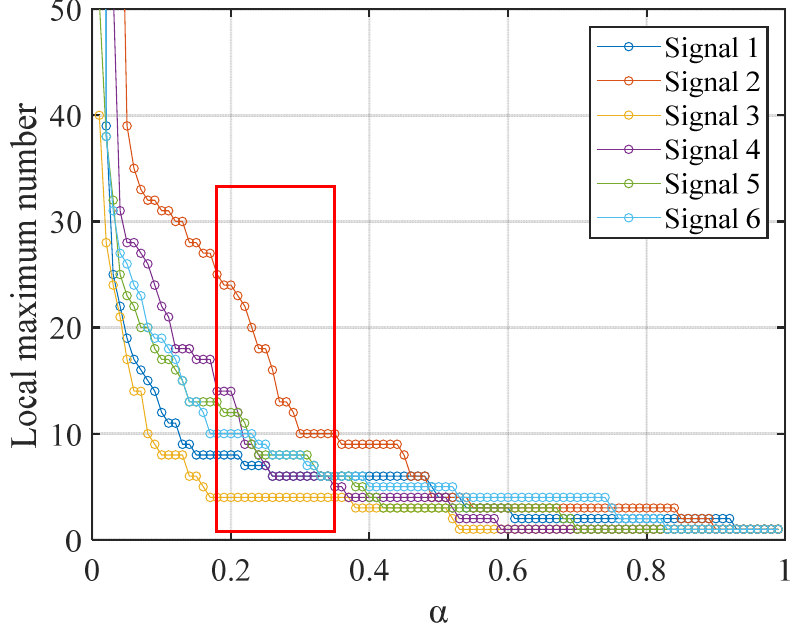
Figure 3. Variation in the numbers of local maxima above the threshold along with α . To minimize the influence of Fourier axis segmentation on EWT, the split point takes the local minimum value of the Fourier spectrum of the area corresponding to the inter- section of the middle 3/5 area of two adjacent frequency points and the local minimum values of the closing operation result. If there is no intersection, the local minimum value of the Fourier spectrum of the 3/5 area is taken as the split point. In addition, (1) if the closing operation curve rises monotonically between 0 and the first frequency point, this section will not be divided; (2) to ensure that the component corresponding to the last obtained local maximum is decomposed pertinently, this frequency point plus 10 times the drawing frequency resolution (i.e., 10 kHz) serves as a split point; (3) between the frequency of this split point and π , the midpoint of these two frequency points is taken as a split point. Thus, in general, if there are n local maxima, the final Fourier axis will be divided into n + 2 or n + 3 segments. For the Fourier axis of the example EMR waveform, M M , M 1 , and α are 0.0186 V, 0.1519 mV, and 0.18, respectively, so the threshold is 0.0035 V, as shown by the red dotted line in Figure 4. The number of local maxima larger than the threshold is seven, and then the Fourier axis is divided into nine segments corresponding to nine filter banks, as shown by the magenta lines in Figure 4. Compared with the result of the conventional Fourier axis segmentation shown in Figure 1b, the segmentation result shown in Figure 4 avoids the phenomenon that the adjacent local maxima are improperly separated. Moreover, the segmentation lines all lie on the local minimum values of the segments of the Fourier spectrum, and keep a distance of at least 1/5 of the segment width from the local maxima, minimizing the adverse impact of Fourier axis division on the signal time–frequency Figure 4. Adaptive segmentation result of the Fourier axis based on DFT and closing operation.